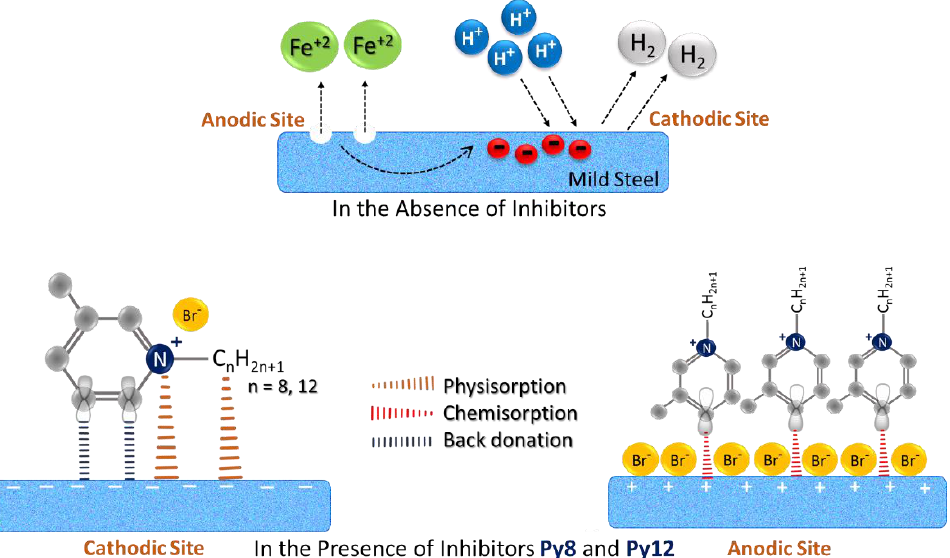
Figure 14. Schematic illustration of the corrosion of EN3B mild steel immersed in 3.5% NaCl solution at pH 1.5 and its inhibition in the presence of Py8 and Py12 molecules.